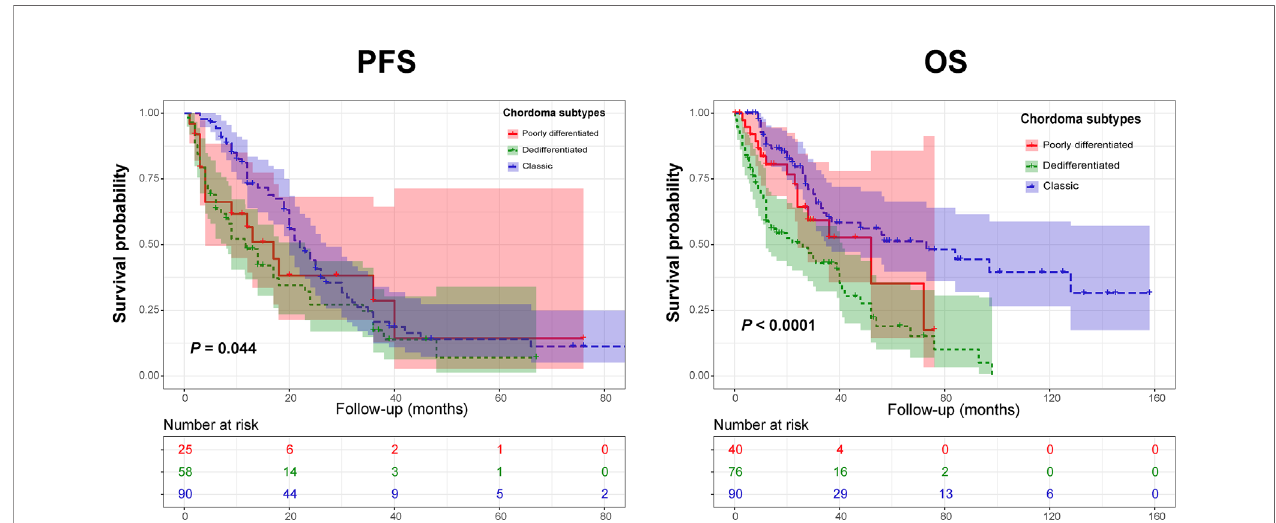
FIGURE 2 | Kaplan-Meier curves of progression-free survival ( Left ) and overall survival ( Right ) of chordoma patients strati fi ed by tumor pathology